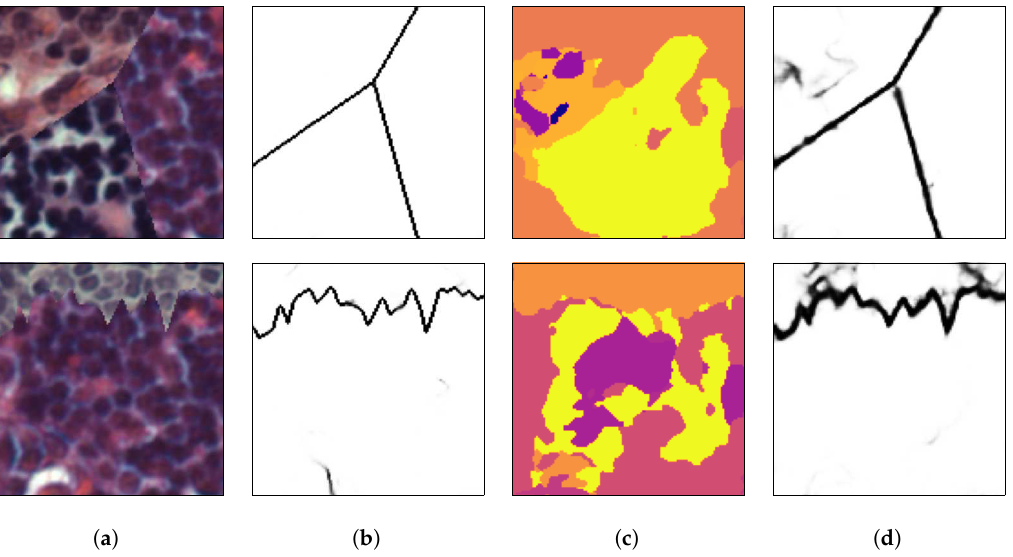
Figure 21. ( a ) An example mosaic, ( b ) the results of a multi-class labeling approach, ( c ) a HED architecture, and ( d ) the proposed